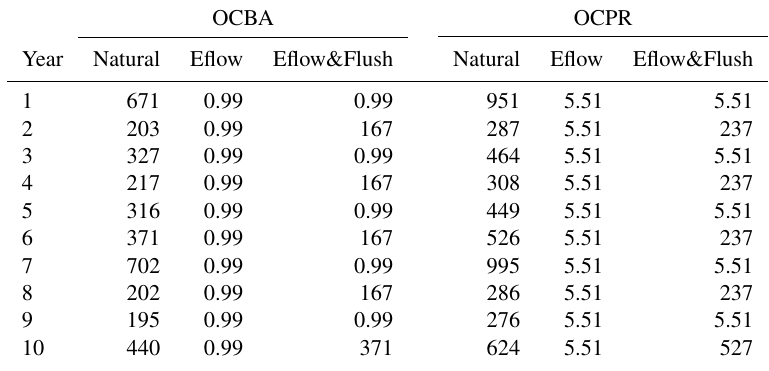
Table 1. Maximum annual discharges (m 3 s − 1 ) considered in the CASiMiR-vegetation model for each study